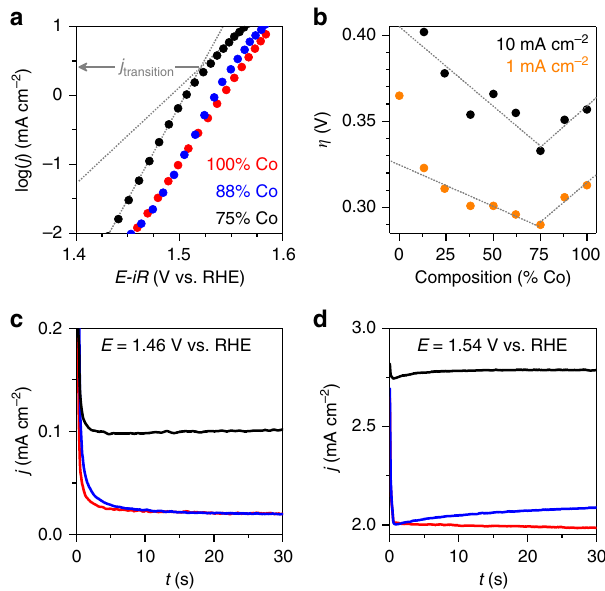
Fig. 2 Electron transfer kinetics for representative Fe – Co oxides. a Tafel plots obtained from 60 s chronoamperometric measurements in 1 M KOH (aq) . Trend lines are included for 75% Co to highlight the transition in Tafel slope. b Overall electrocatalytic OER performance as a function of fi lm composition; trend lines shown to highlight the trends. c , d Current densities recorded following +10 mV potential steps to 1.46 and 1.54 V vs. RHE depicting the transient behavior in the two linear Tafel regimes from a